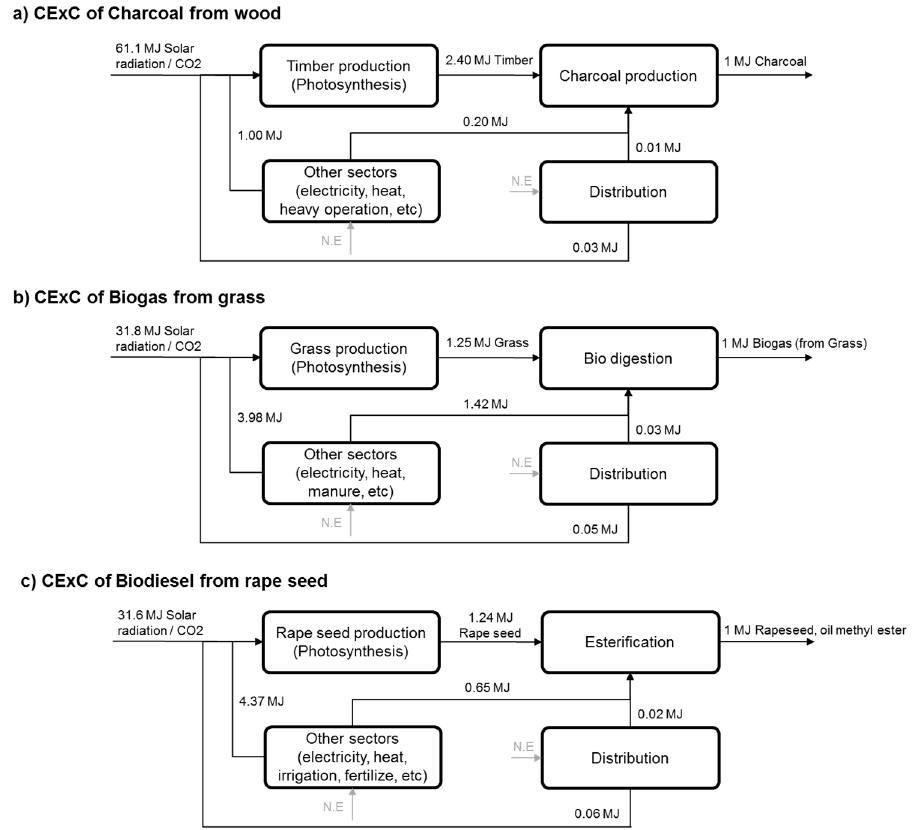
Figure 5. Example of CExC calculations for charcoal, biogas from grass and biodiesel from rapeseed.